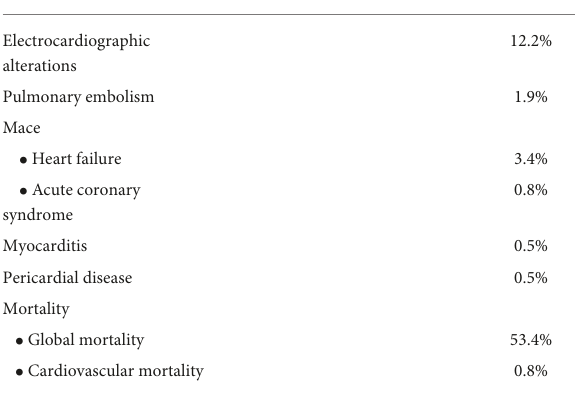
TABLE 3 Global incidence of cardiovascular events during ICI